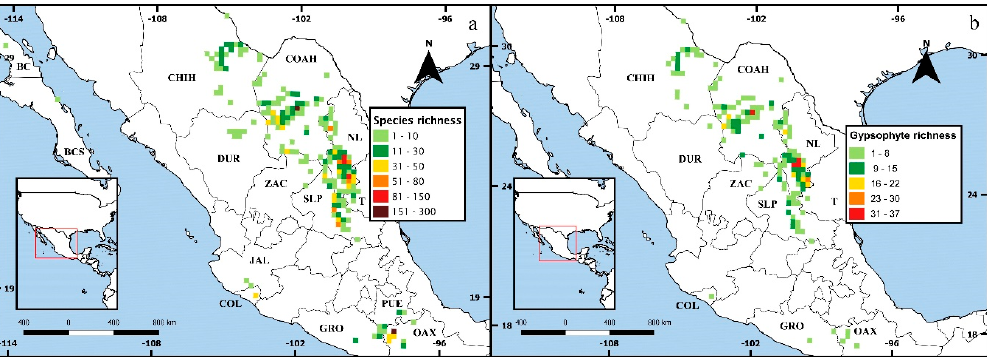
Figure 3. Spatial distribution of species richness within the gypsicolous flora in Mexico: ( a ) all species recorded and ( b ) gypsophytes.